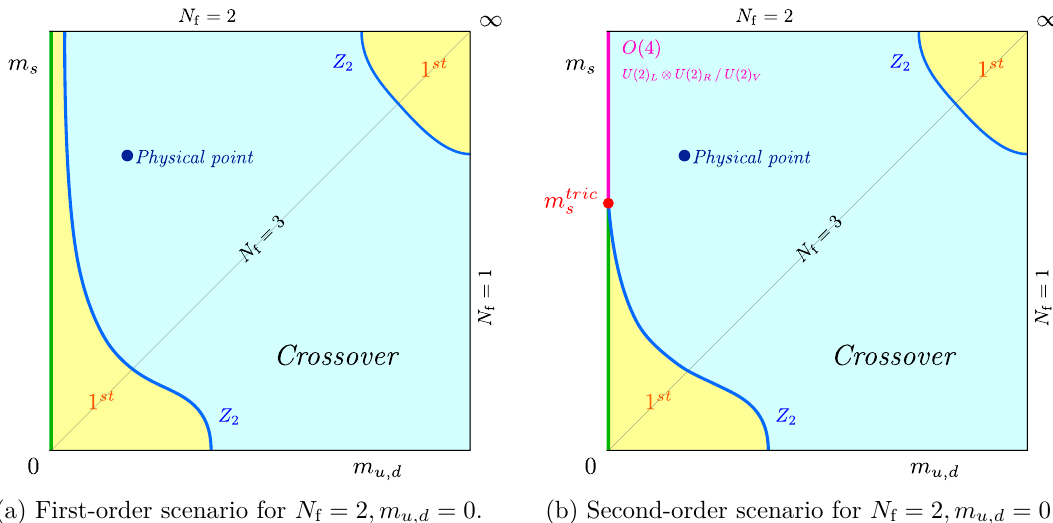
Figure 1. Possible scenarios for the order of the thermal QCD transition as a function of the quark masses. Every point of the plot represents a phase boundary, with an implicitly associated (pseudo-)critical temperature T c ( m u,d , m s )